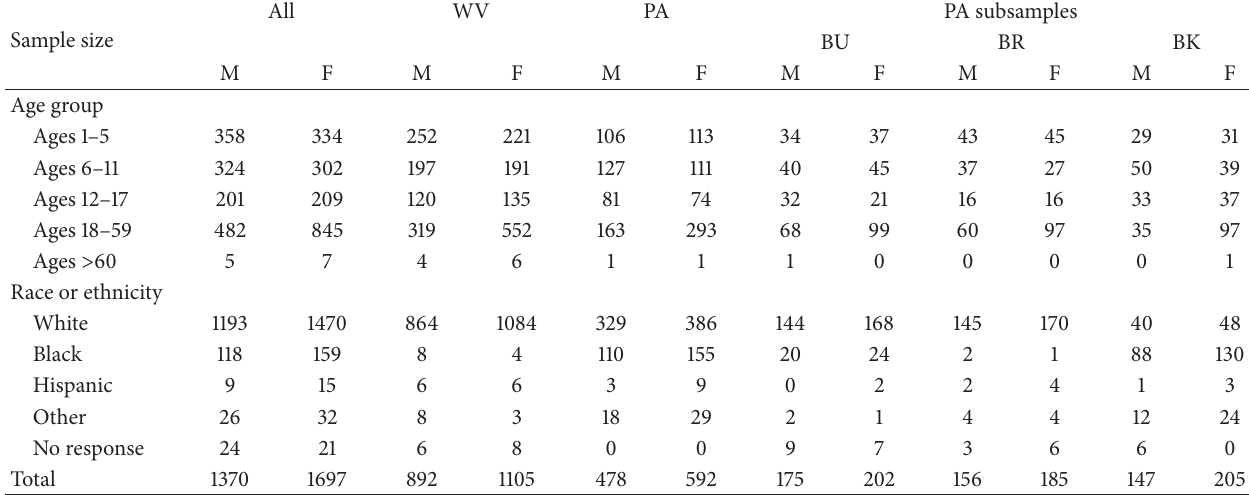
Table 1: Composition of the COHRA1 sample as indicated by sample size for each